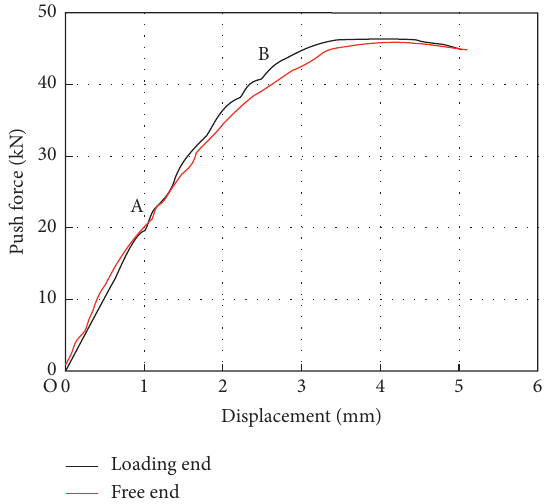
Figure 8: Bond-slip curves of the loading end and the free end.